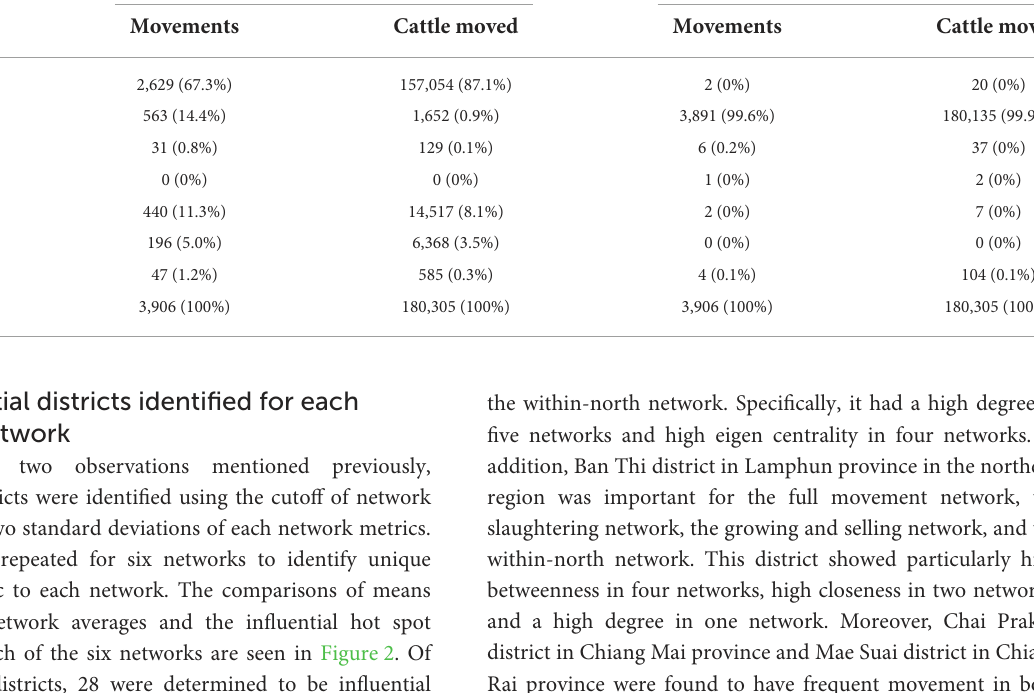
TABLE 7 Dairy cattle movements (frequency) and the number of cattle moved (animal head) between districts in northern Thailand with different regions as origin and destination from 2010 to 2017. Regions Origin Destination Movements Cattle moved Movements Cattle